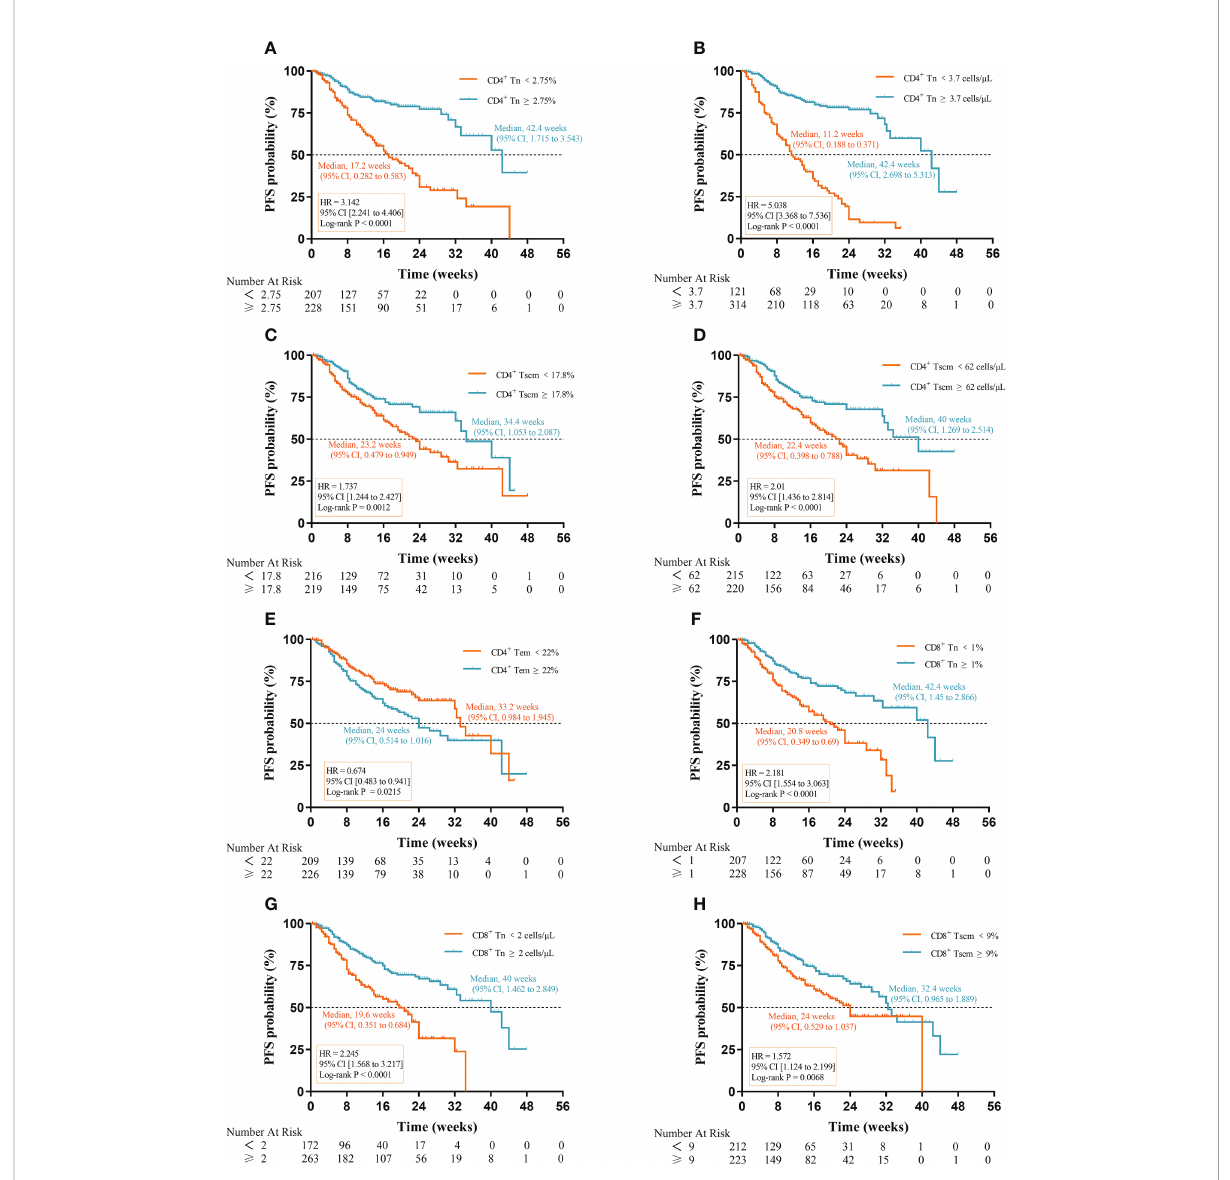
FIGURE 5 PrognosticimpactofTn/TmonPFSofaNSCLCs: (A) ThepercentageofCD4 + Tn ontheprognosisof PFS. (B) TheACof CD4 + Tnonthe prognosisof PFS. (C) ThepercentageofCD4 + Tscmon theprognosisof PFS. (D) TheACof CD4 + Tscmontheprognosisof PFS. (E) The percentageof CD4 + Temonthe prognosisof PFS. (F) Thepercentage of CD8 + Tnonthe prognosisof PFS. (G) The ACof CD8 + Tnon theprognosisofPFS. (H) Thepercentage of CD8 + Tscmonthe prognosisof